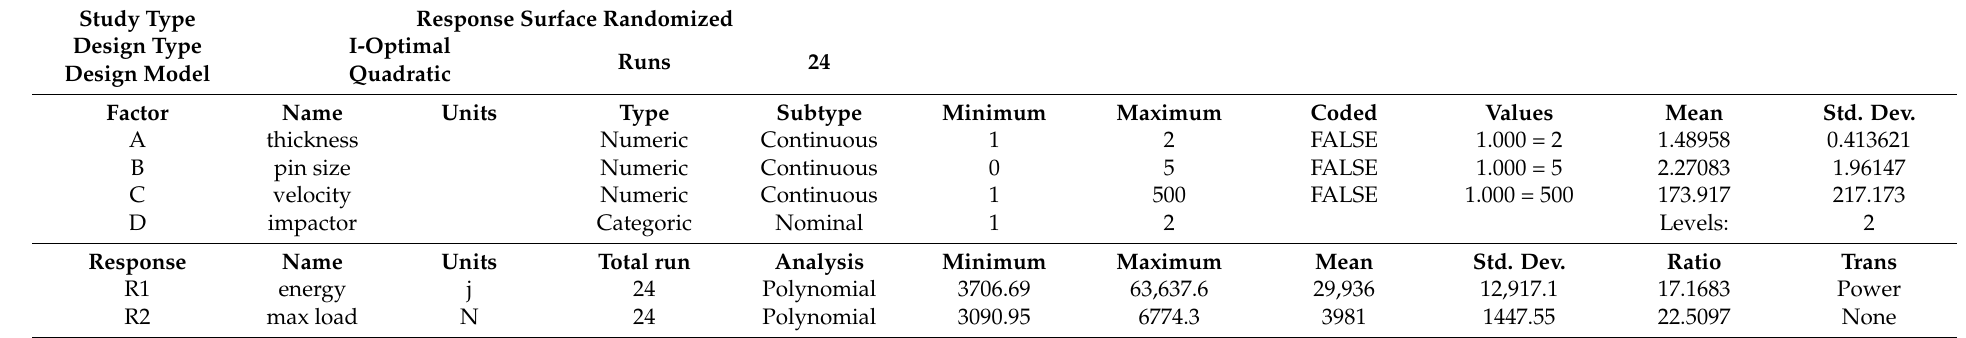
Table 2. The specifications of the DOE design